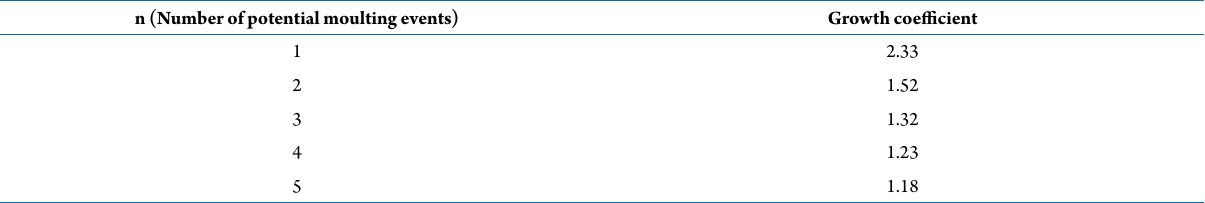
Table 1. Growth coefficients calculated for Electrolana madelineae sp. nov. for different numbers of moults assumed to have happened between the preserved stages, calculated based on the overall-body length of the holotype and the paratype. n (Number of potential moulting